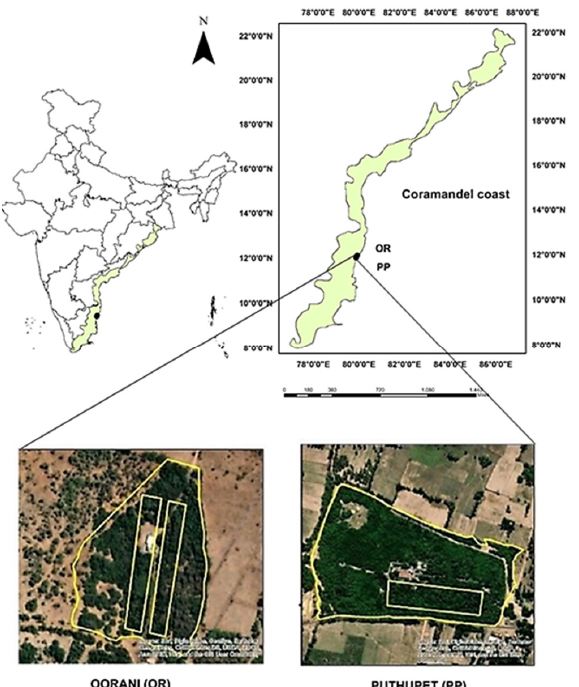
Figure 1. Map showing the location of two tropical dry evergreen forest sites on the Coromandel coast of southern India (Oorani - OR and Puthupet - PP) Table 2. Disturbance score (0 = none, 1 = low, 2 = medium, 3 = high, 4 = very high) for two tropical dry evergreen forest sites (OR - Oorani and PP - Puthupet) on the Coromandel coast of peninsular India